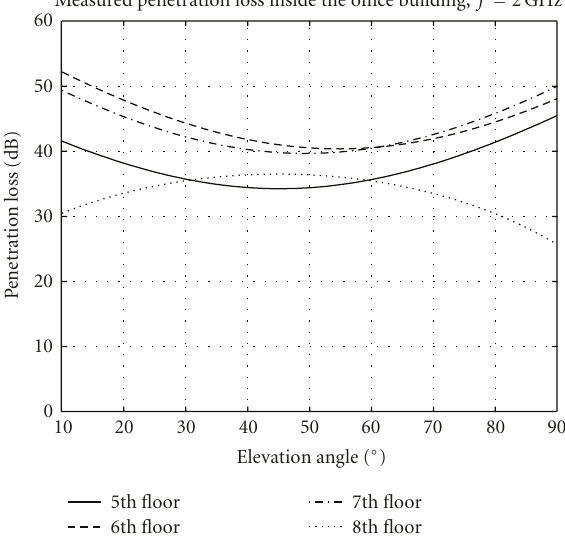
Figure 5: Penetration loss as a function of the elevation angle for range of floors in o ffi ce building, f = 2 . 0 GHz.